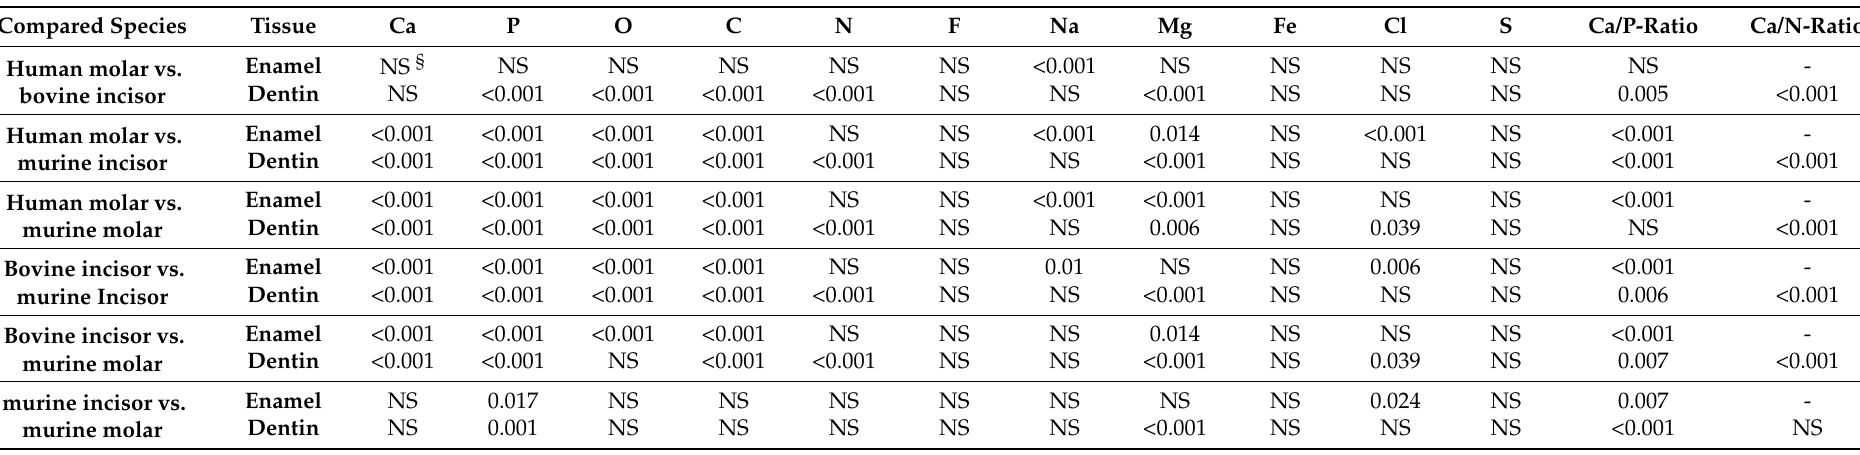
Table 4. p -values from pairwise tests between the groups of teeth for each dental hard tissue and all elements examined (summarized areas), as well as for the Ca/P- and Ca/N-Ratios (results in Figure 5 and Table